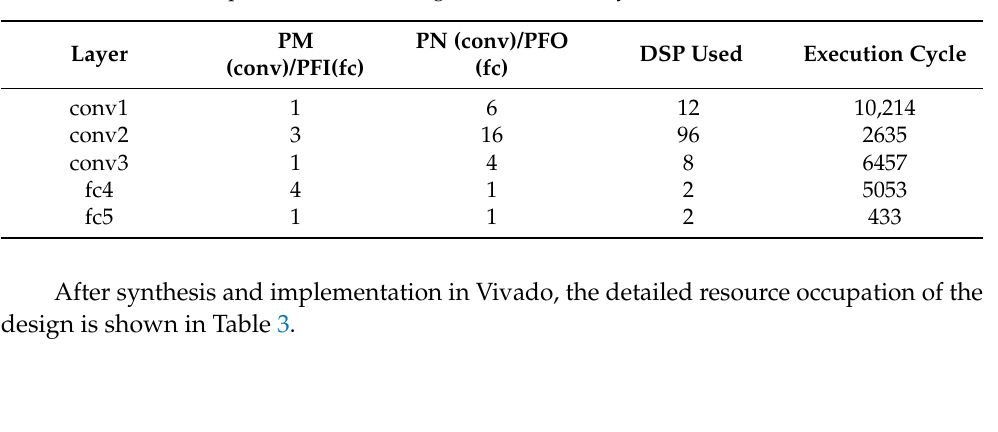
Table 2. Parameters of parallelism, DSP usage and execution cycle of